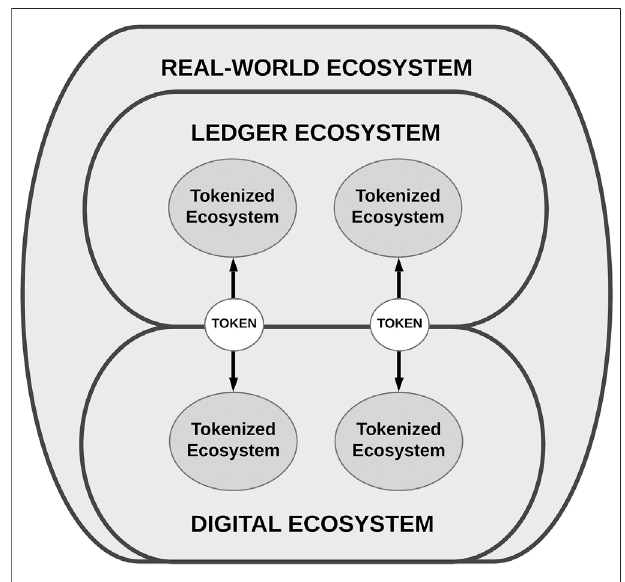
FIGURE 1 | Tokens bridging ecosystems of